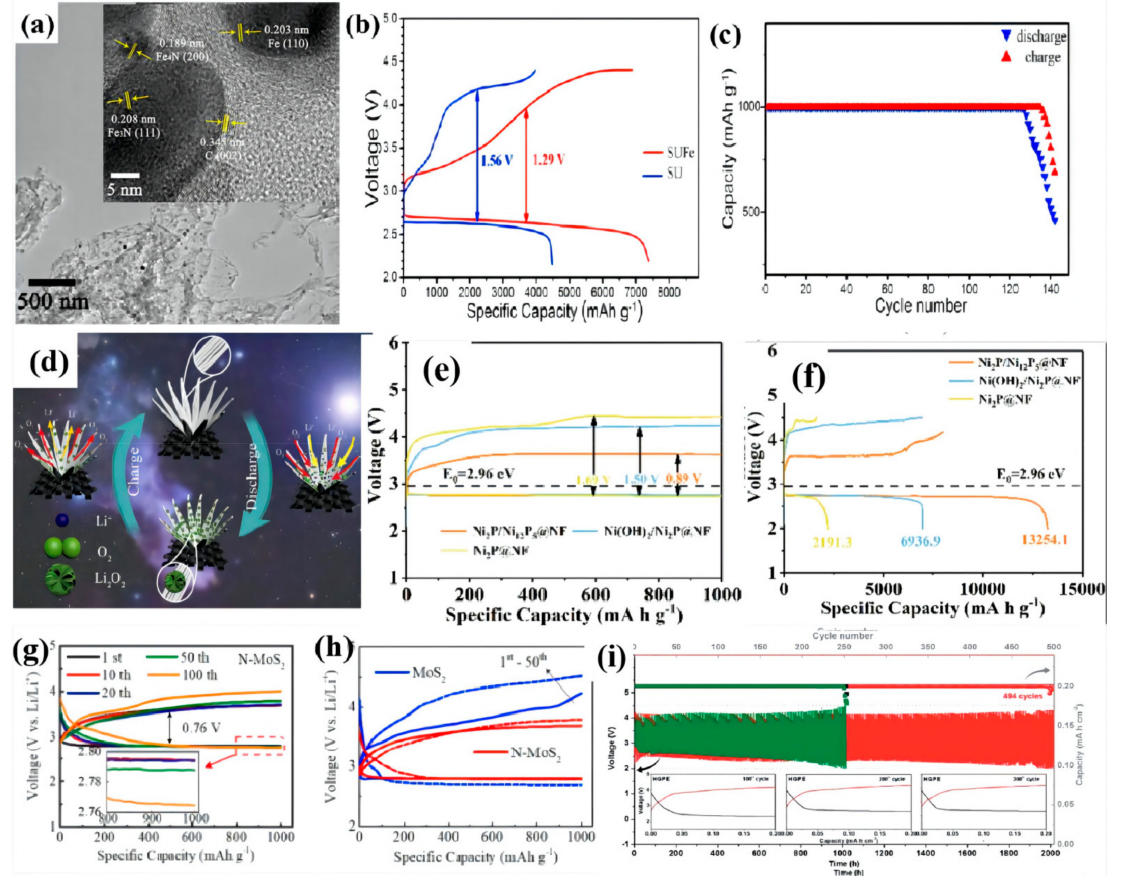
Figure 13. ( a ) TEM images of the Fe/Fe 3 N/Fe 4 N@NG nanocomposites (SUFe), ( b ) The